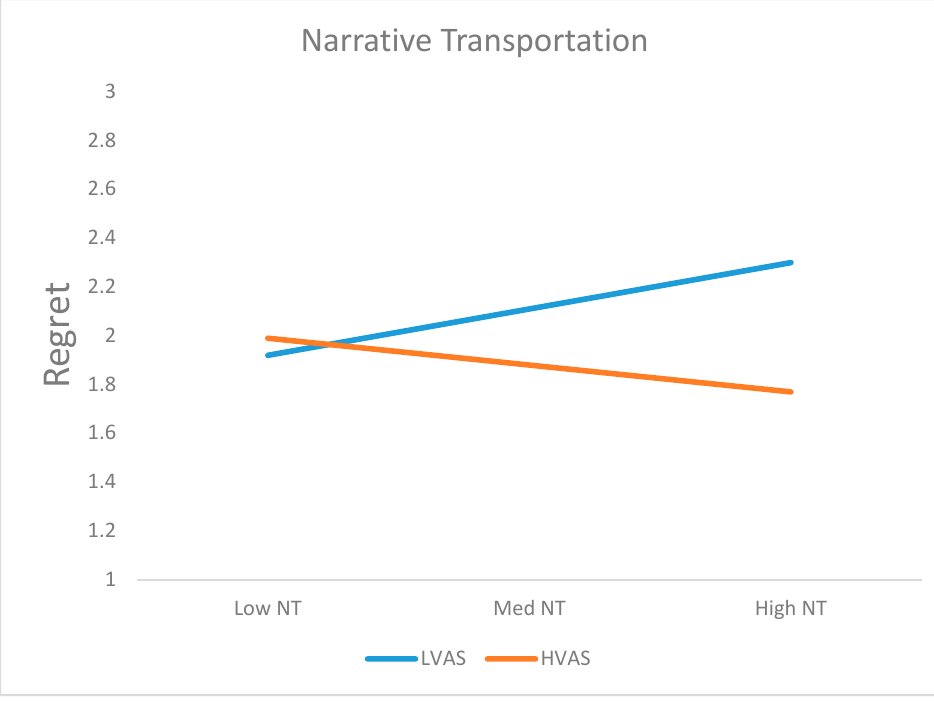
Figure 3. Attentiveness moderates narrative transportation and regret.